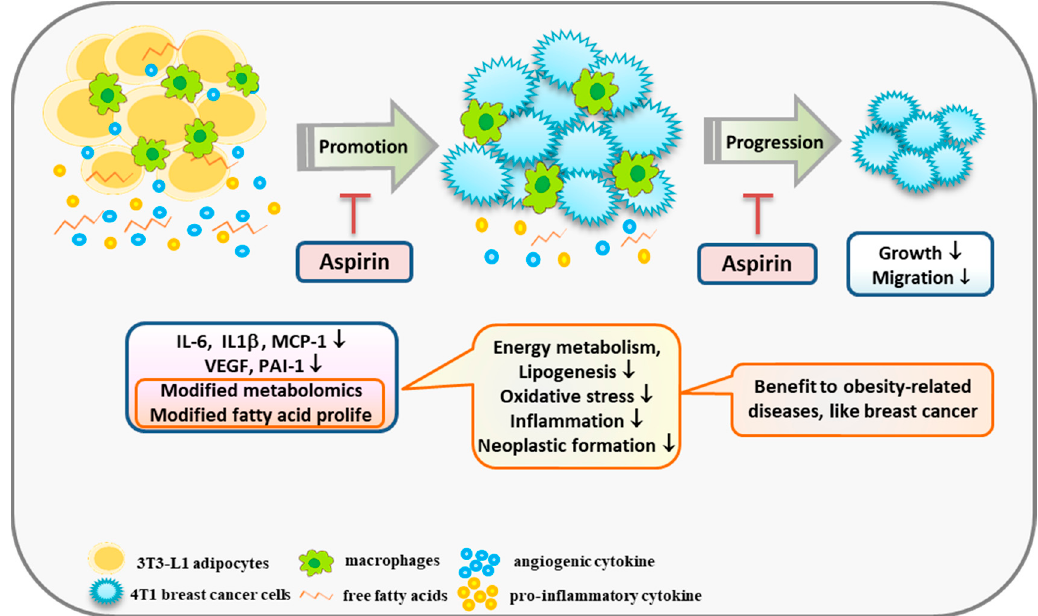
Figure 6. A scheme displaying a possible mechanism by which aspirin modifies obesity-related mediators and metabolomics profiles, resulting in suppression of the growth of breast cancer cells.